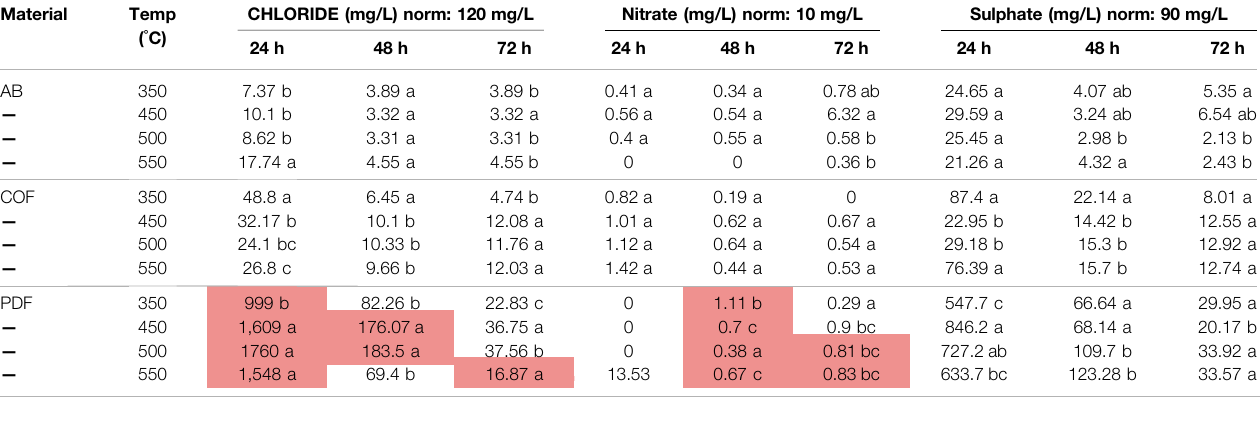
TABLE 2 | Leaching of chloride, nitrate and sulphate after 24, 48, and 72 h for the 3 types of biochars produced at 4 temperatures. The norms are the thresholds set in the VLAREM-II for surface water quality. Values above the norm are colored in red. Values with the same letter do not indicate a signi fi cant difference p < 0.05, n = 4. PDF: palm date fi ber, COF: coffee bean husks, AB: waste wood mix. Material